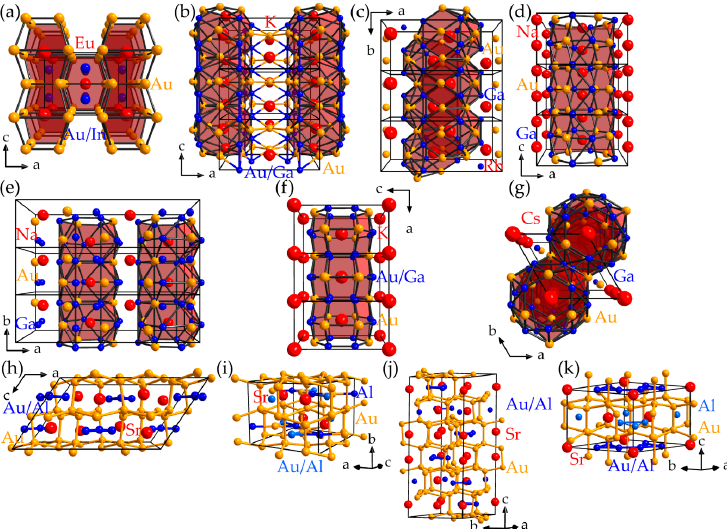
Figure 6. Representations of the crystal structures of: ( a ) EuAu 5.0 In 1.0 ; ( b ) KAu 3.1 Ga 1.9 ; ( c ) RbAu 3 Ga 2 ; ( d ) Na 0.6 Au 2 Ga 2 ; ( e ) NaAu 2 Ga 4 ; ( f ) KAu 2.2 Ga 3.8 ; ( g ) CsAu 5 Ga 9 ; ( h ) Sr 2 Au 7.3 Al 1.7 ; ( i ) SrAu 5.1 Al 1.9 ; ( j ) Sr 2 Au 6.2 Al 2.8 ; and ( k ) SrAu 4.1 Al 2.9 . Details regarding the crystal structures and their determinations may be extracted from the main text and the literature listed in Table 4,